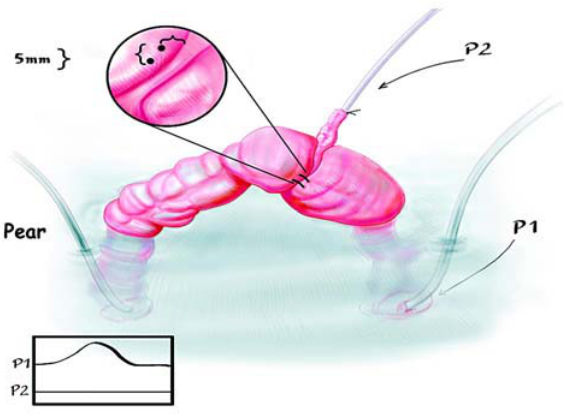
Figure 3 – Standardization of continence line distance of seromuscular stitches at the intestine.